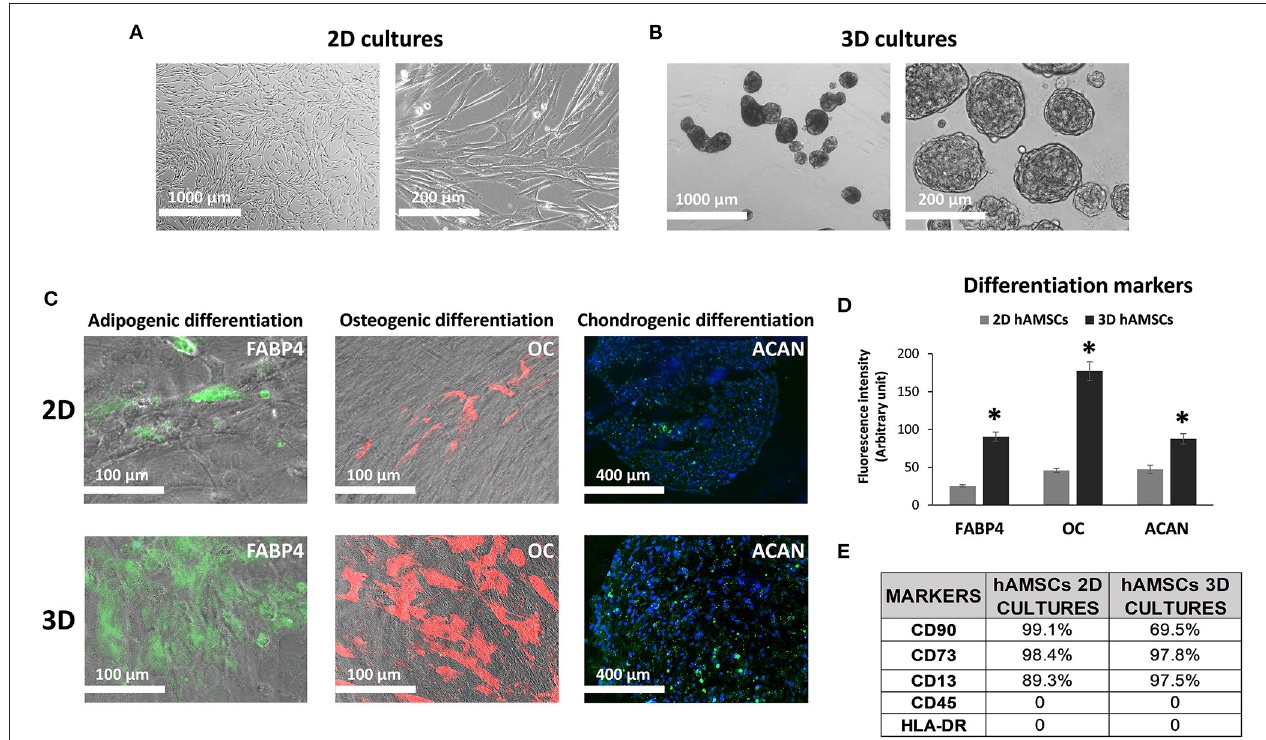
FIGURE 2 | Human amnion-derived mesenchymal stem cells (hAMSCs) cultured as both monolayer and spheroids. (A) Representative DIC images of hAMSCs grown in monolayer (2D cultures). (B) Representative DIC images of hAMSCs grown as spheroids (3D cultures). (C) Immunofluorescence staining localization of fatty acid binding protein 4 (FABP4), Osteocalcin (OC), and Aggrecan (ACAN) in hAMSCs grown as both monolayer and spheroids. (D) Graphic depicts FABP4, OC, and ACAN fluorescence intensity in hAMSCs grown as both monolayer and spheroids. (E) Cytofluorimetric analysis of the surface marker in hAMSCs grown in 2D cultures and 3D cultures at passage 2. DIC, differential interference contrast. * p < 0.05 vs. 2D